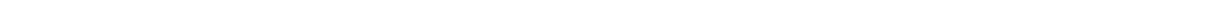
Fig. 3 Galectin-3 in human tumors impedes CXCL9 induction by IFN γ . a Galectin-3 surface staining of melanoma cell line LB33-MEL. Control isotype staining is depicted in gray and galectin staining in black . b CXCL9 mRNA fold induction in LB33-MEL incubated for 4 h with IFN γ (50 ng ml − 1 ), LacNAc (5 mM), sucrose (5 mM), and/or a neutralizing anti-IFN γ R1 antibody (5 μ g ml − 1 ). Fold induction CXCL9 values were calculated using HPRT-1 as reference gene and with respect to IFN γ − treated condition (2 − ΔΔ Ct ). Mean ± SD of 3 – 10 experiments. *** P < 0.001 ** P < 0.01; Kruskal – Wallis test with Dunn ’ s Multiple Comparison Correction Test. c CXCL9 mRNA fold induction in LB33-MEL xenografts treated ex vivo for 6 h with IFN γ (50 ng ml − 1 ), LacNAc (10 mM), and/or different antibodies (10 μ g ml − 1 ). Each point represents one tumor. Mean ± SEM of eight independent experiments. ** P < 0.01 * P < 0.05; Wilcoxon matched-pairs signed rank test with Dunn ’ s Multiple Comparison Correction Test. d , e CXCL9 mRNA fold induction for SKBR3-Gal3GFP ( d ) and SKBR3-Gal3mutGFP ( e ) xenografts treated for 6 h ex vivo with IFN γ (50 ng ml − 1 ), LacNAc (10 mM), GM-CT-01 (100 μ g ml − 1 ), and/or antibodies (10 μ g ml − 1 ). Mean ± SEM of two independent experiments where pieces were pooled from 12 tumors SKBR3-Gal3GFP and 16 tumors SKBR3-Gal3mutGFP. *** P < 0.001; Wilcoxon matched-pairs signed rank test with Dunn ’ s Multiple Comparison Correction